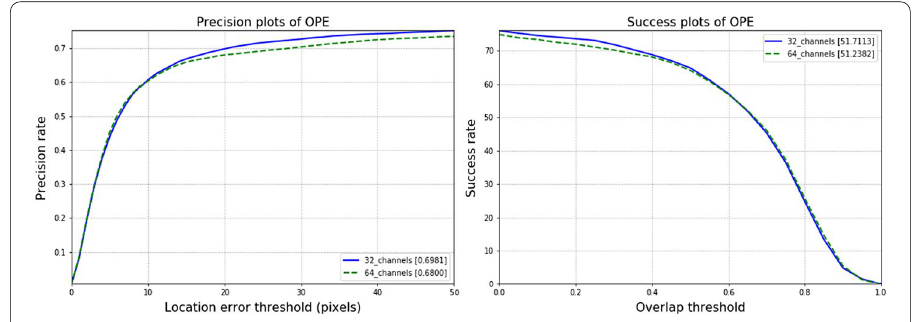
Fig. 8 Success and precision plots on OTB2013 datasets with different network structure